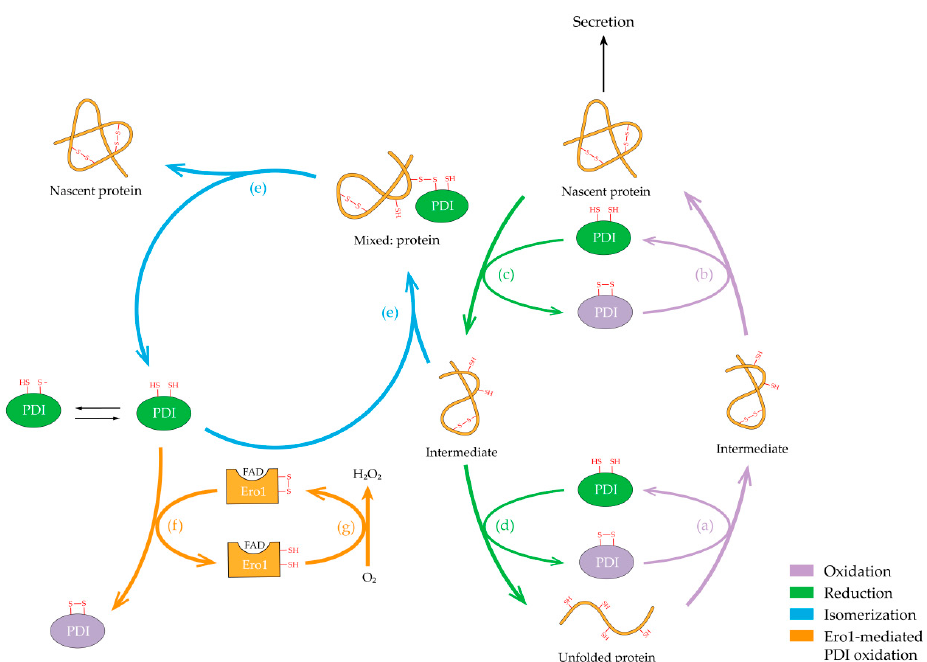
Figure 3. The pathway of PDI catalyzed disulfide formation and isomerization in the ER. Unfolded protein is catalyzed by oxidized PDI, resulting in the formation of intermediate ( a ), which can further be oxidized to generate nascent protein possessing biological functions ( b ). Reduced PDI catalyzes the reduction of disulfide bonds in nascent peptide to facilitate substrate unfolding ( c ), and form an unfolded protein eventually ( d ). It is worth noting that the oxidation/reduction path- way involves repeated cycles of oxidized/reduced PDI. PDI would carry out the isomerization pathway, in which a mixed substrate protein is generated, if the intermediate is misfolded ( e ). After substrate thiol oxidation, oxidized PDI can be regenerated though an alternative pathway ( f ). Endoplasmic reticulum oxidoreductase 1 (Ero1) containing flavin adenine dinucleotide (FAD), which uses O 2 to reoxidize itself for further folding cycles ( g ), plays a dominating role in this way. Mauve indicates the oxidation process, green indicates the reduction process, blue indicates the isomerization process, orange indicates the Ero1-mediated PDI oxidation process.